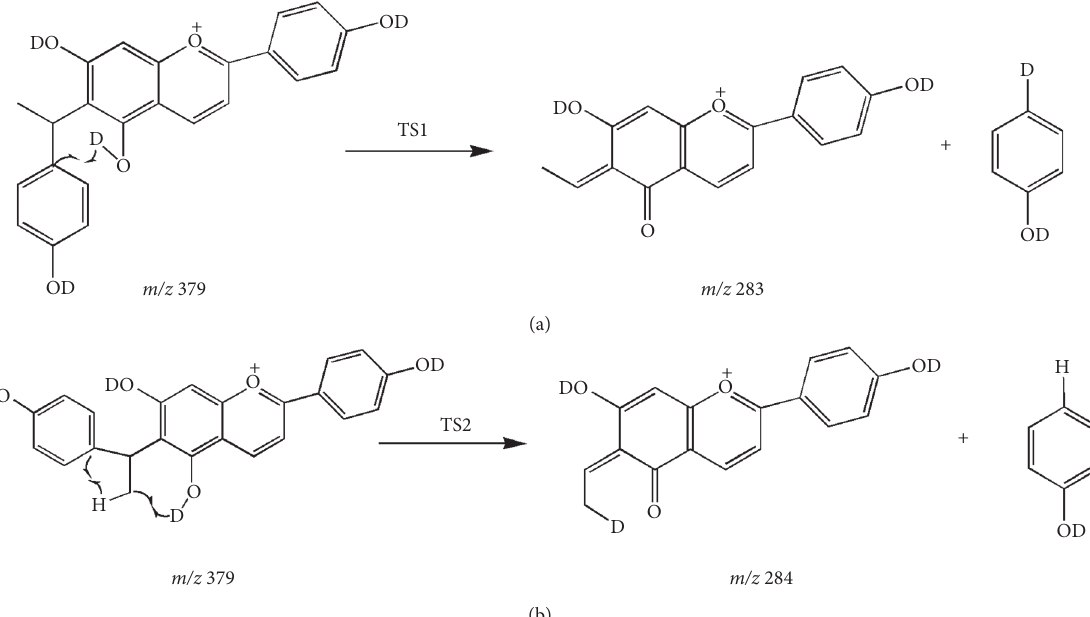
Figure 3: Proposed fragmentation pathways for deuterated fragmented ions of compound 7. (a) The pathway for m/z 283 via TS1; (b) the pathway for m/z 284 via